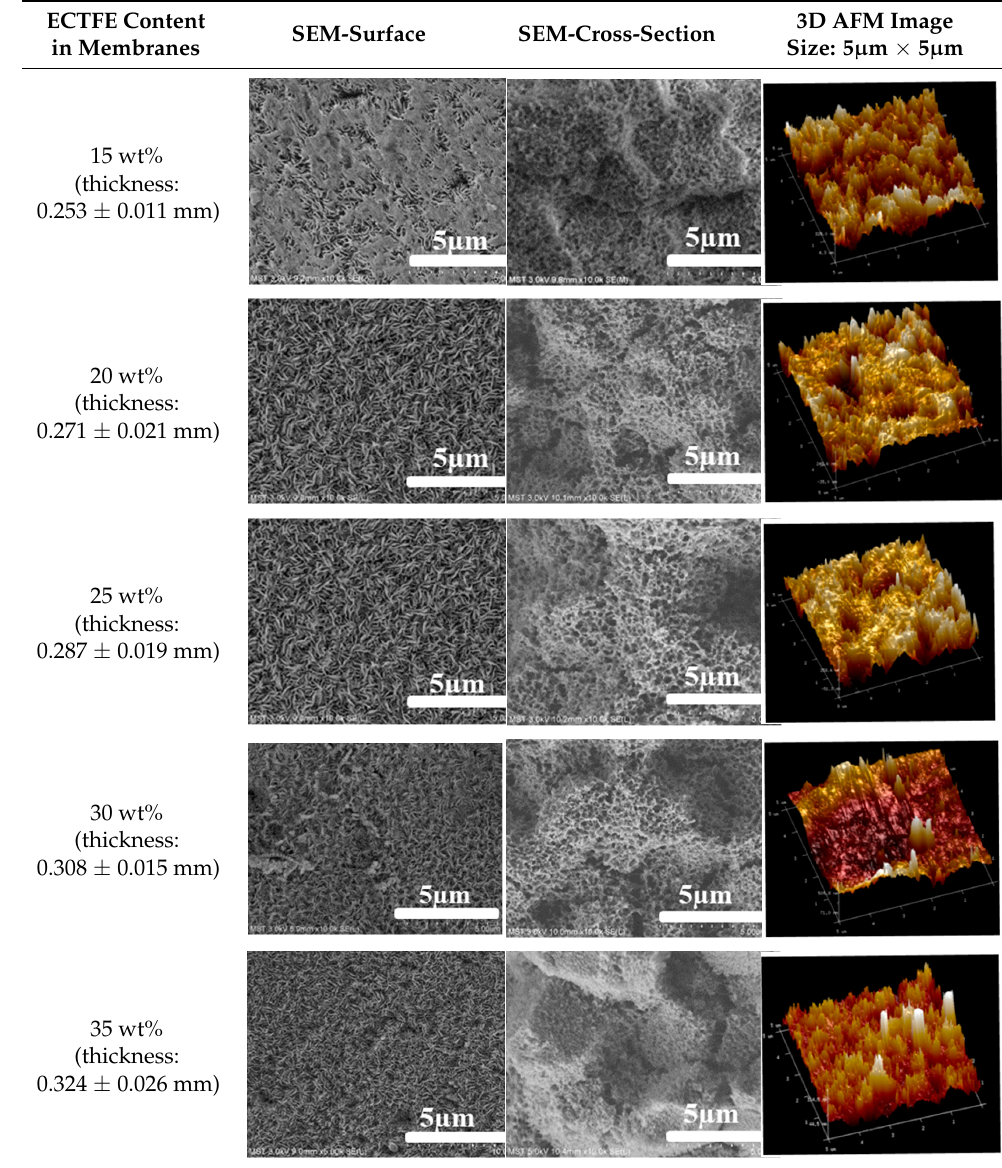
Table 5. SEM and AFM images of ECTFE